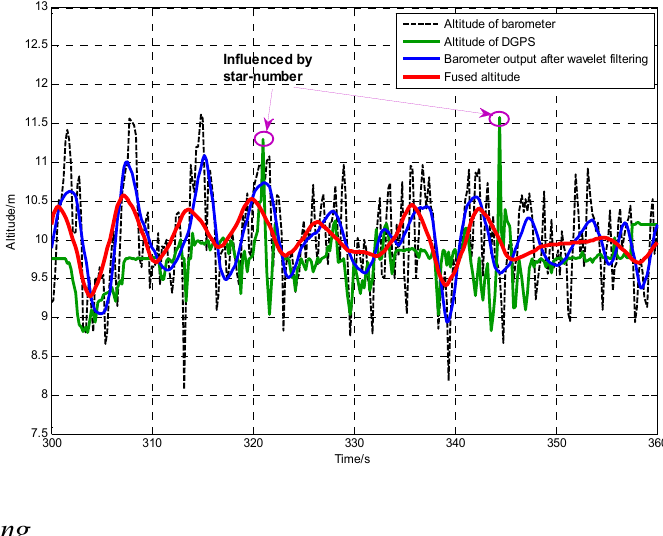
Figure 6. The altitude generated by the AEKF method, barometer and DGPS in a hovering process.